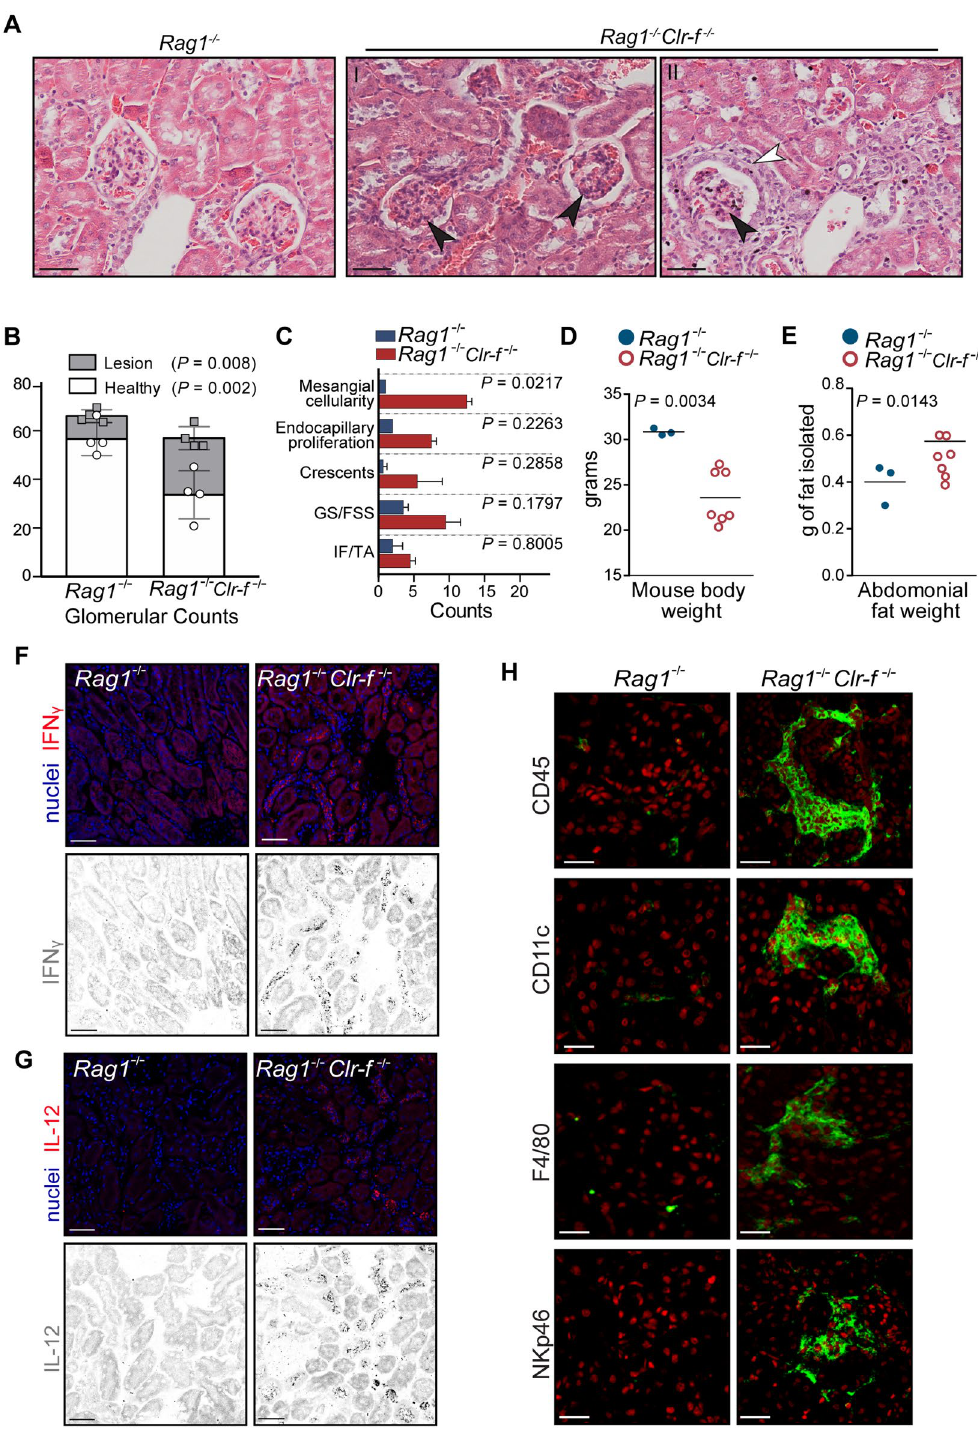
Figure 7. Presence of T and B cell-independent kidney pathology in Clr-f −/− mice. ( A ) Light microscopy images of H & E-stained kidney section from Rag1 −/− and Rag1 −/− Clr-f −/− mice. Rag1 −/− Clr-f −/− kidneys shown in (I and II) exhibit glomerular hypercellularity (black arrowheads) and Rag1 −/− Clr-f −/− kidney shown in (II) exhibit fibrosis (white arrowheads). Scale bars represent 50 μm. ( B ) Scoring of glomerular lesions in Rag1 −/− and Rag1 −/− Clr-f −/− H&E-stained kidney sections. Each point represents glomeruli number per kidney that exhibited no overt pathology (circles) or exhibited pathological lesions (squares). Stacked columns indicated score means and error bars represent standard deviation. ( C ) Scoring of mesangial cellularity, endocapillary proliferation, crescents, glomerulosclerosis, or global or focal segmental sclerosis (GS/FSS), and interstitial fibrosis and tubular atrophy (IF/TA). Counts represent the average number of lesions per kidney section (n = 2 mice). Error bars represent standard deviations. ( D ) Measurement of total body weight for indicated mouse genotypes. ( E ) Measurement of total abdominal fat weight dissected from mice of the indicated mouse genotypes. Horizontal bars represent the mean weight. ( F ) IF staining of kidney sections for IFNγ ( G ) and IL-12 cytokines in Rag1 −/− and Rag1 −/− Clr-f −/− mice. Scale bars represent 40 μm. ( H ) IF staining of Rag1 −/− and Rag1 −/− Clr-f −/− mice with antibodies against CD45, CD11c, NKp46, or F4/80 (green) and nuclear staining with DAPI (in red). Scale bars represent 10